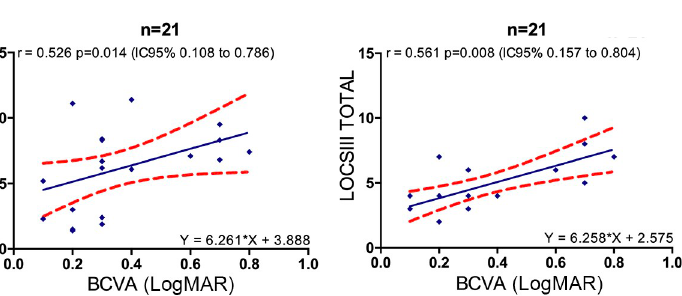
Fig 1. Linear regressions between BCVA and OSI, and between BCVA and LOCS III total. Red dots show the 95% CI of the slope and intercept. OSI = objective scatter index, BCVA = far logMAR best-corrected visual acuity, LOCS III = lens opacity classification system III.